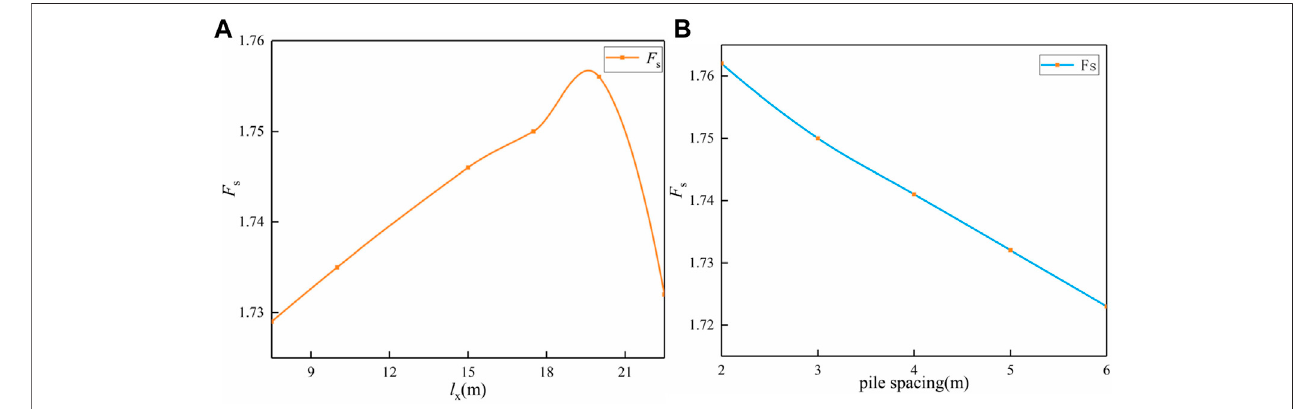
FIGURE 3 | Slope safety factor under different pile positions and different pile spacing without